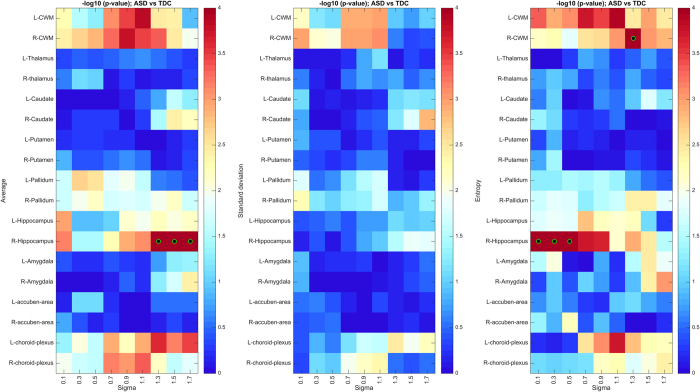
Significance of ASD vs TDC (p-values, −log10 scale) in selected regions, for various filter scales (sigma), following exclusion of 52 volumes based on ABIDE QA.Green-black circles indicate region-scale values with significant p-values following Holm-Bonferroni correction.